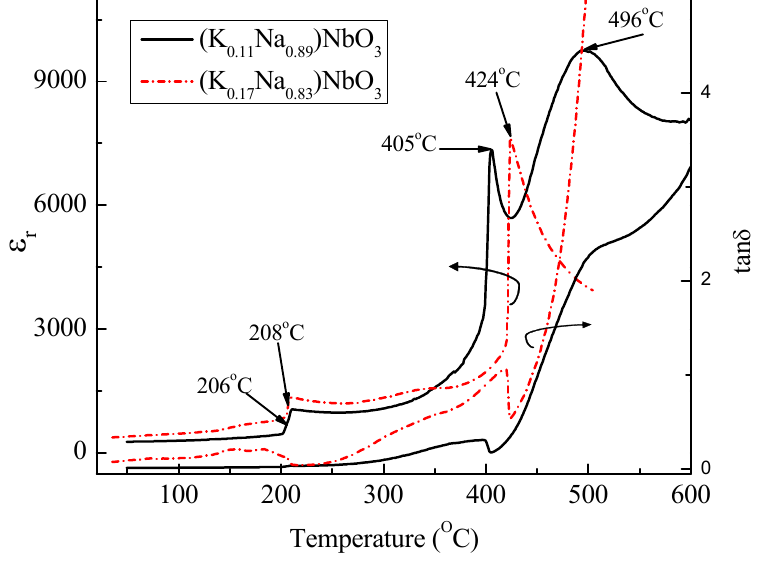
Table 2. As reported in previous work [19,20,22,23], the T X-ray and optic method are inconsistent. Figure 7. Temperature dependence of dielectric permittivity for (K and 0.17) single crystal at 1 kHz.